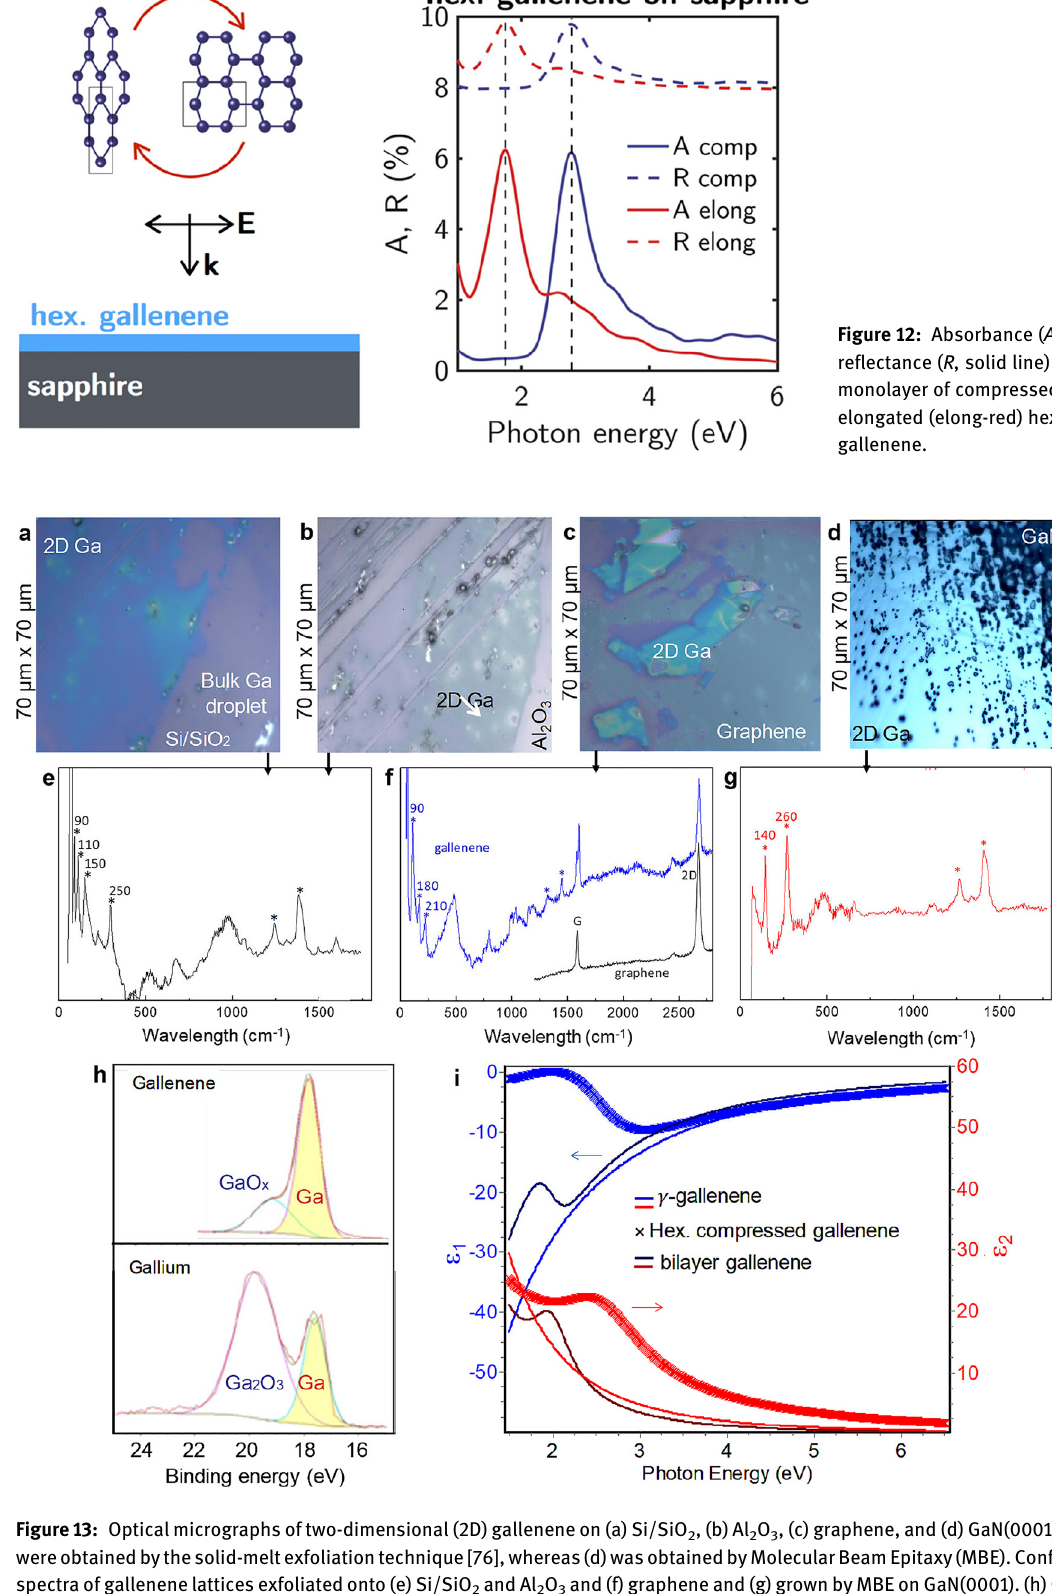
Figure 13: Optical micrographs of two-dimensional (2D) gallenene on (a) Si/SiO 2 , (b) Al 2 O 3 , (c) graphene,and (d) GaN(0001) substrates; (a – c) wereobtainedbythesolid-meltexfoliationtechnique[76],whereas(d)wasobtainedbyMolecularBeamEpitaxy(MBE).Confocalmicro-Raman spectraof gallenenelatticesexfoliatedonto(e)Si/SiO 2 andAl 2 O 3 and(f)grapheneand(g)grown byMBEonGaN(0001).(h)Comparisonof the XPS spectra of the Ga3d photoelectron peak for gallium and gallenene. (i) Dielectric function experimentally determined by ellipsometry of hexagonal compressed gallenene on sapphire, of bilayer gallenene on GaN(0001), and of γ -gallenene on graphene.